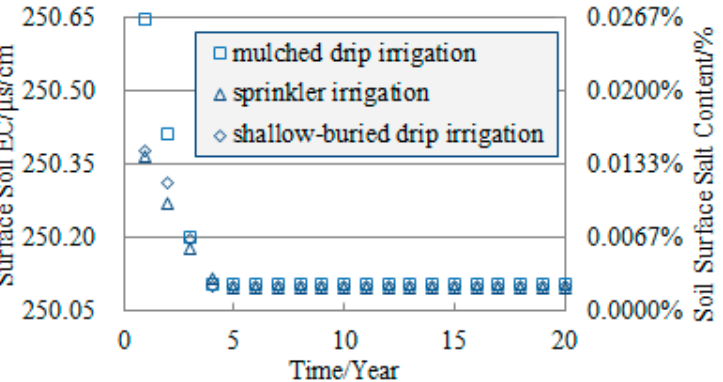
Figure 11. Annual variation in topsoil salinity under three irrigation methods with initial soil EC = 480 μ s/cm (salt content of 0.1%).